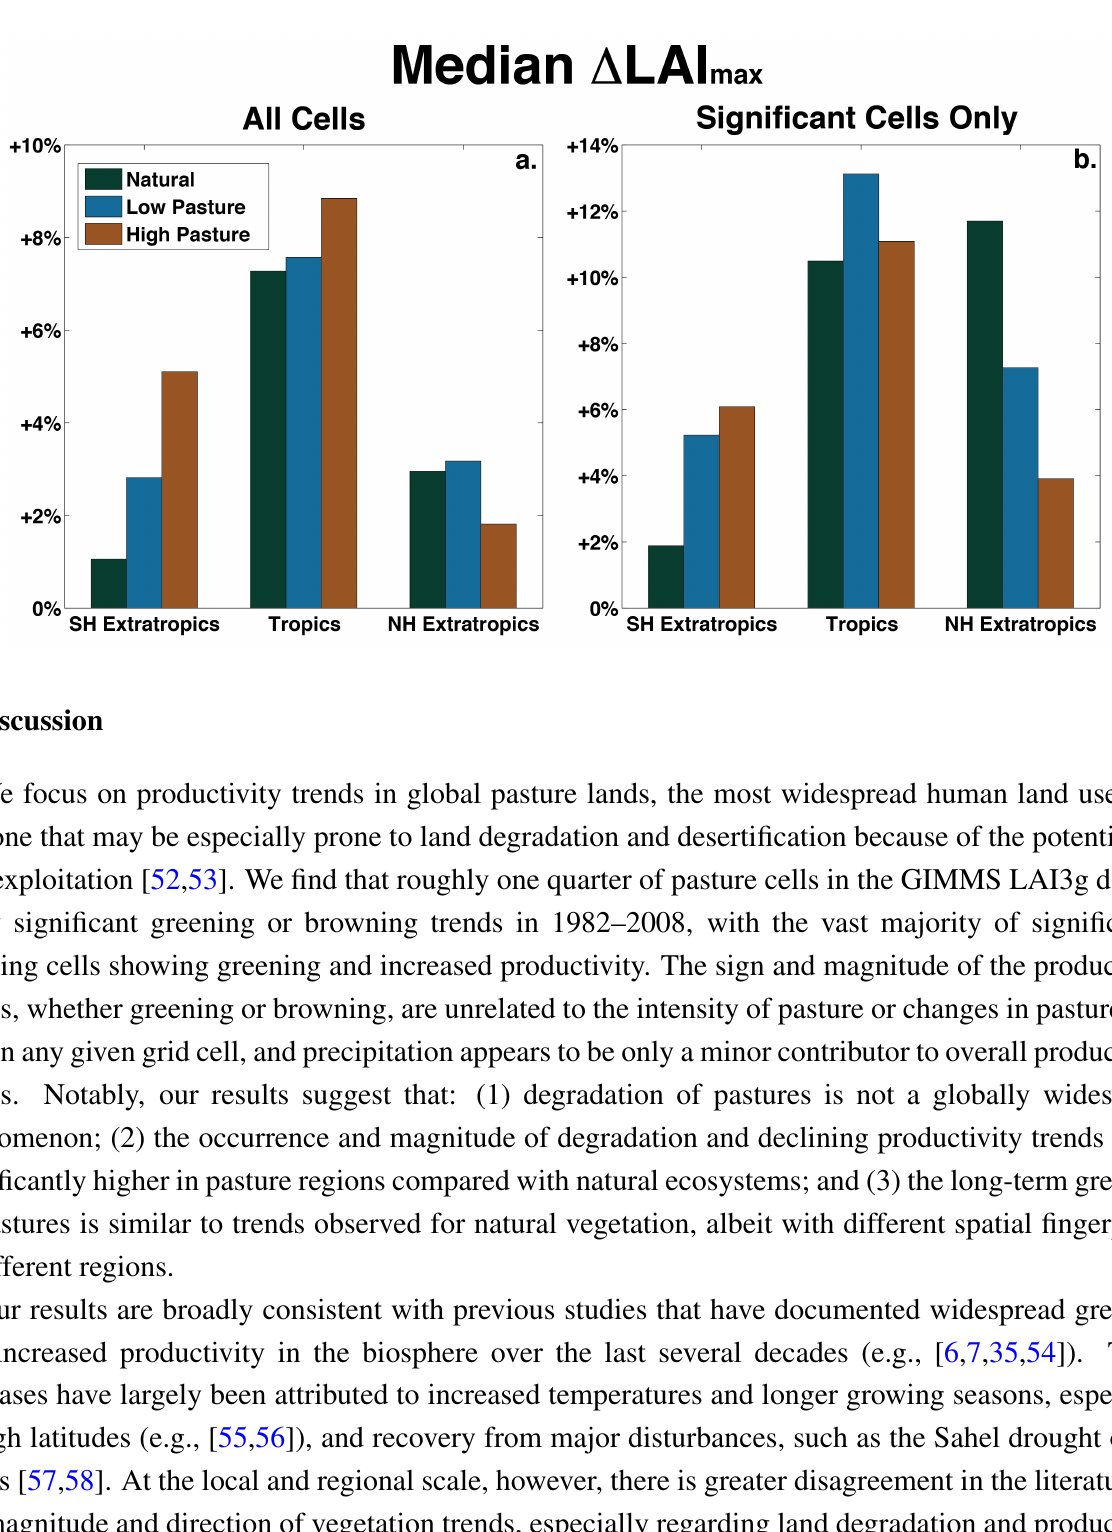
Figure 9. Median change in LAImax for each latitudinal band, calculated across ( a ) all qualifying cells and ( b ) only those cells that pass the three trend test significance